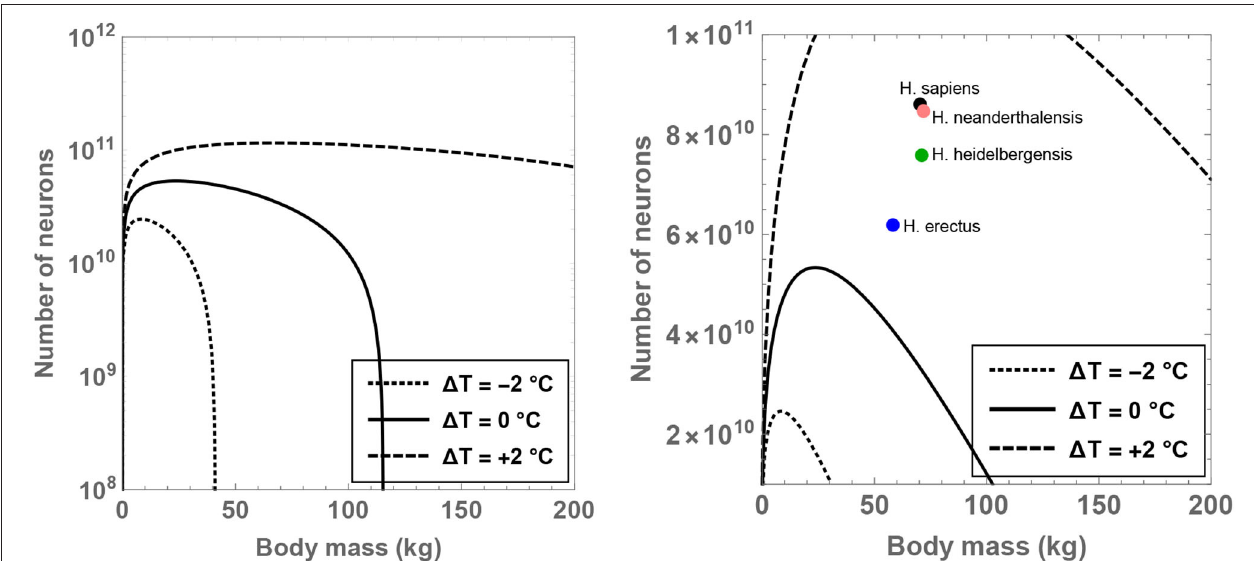
FIGURE 1 | Compatible combinations of the number of neurons ( N ) and body mass ( M BD ) are shown for putative primates that engage in 8 h of feeding per day; the regions lying beneath the curves represent the permitted values. The dotted, unbroken, and dashed curves correspond to body temperatures that differ from present-day humans by − 2, 0, and + 2 ◦ C; the equivalent body temperatures are 35, 37, and 39 ◦ C, respectively. In the right panel (which depicts a narrower range than the left panel), the black, orange, green, and blue dots show the typical values of N and M BD for H. sapiens , H. neanderthalensis , H. heidelbergensis , and H. erectus ,